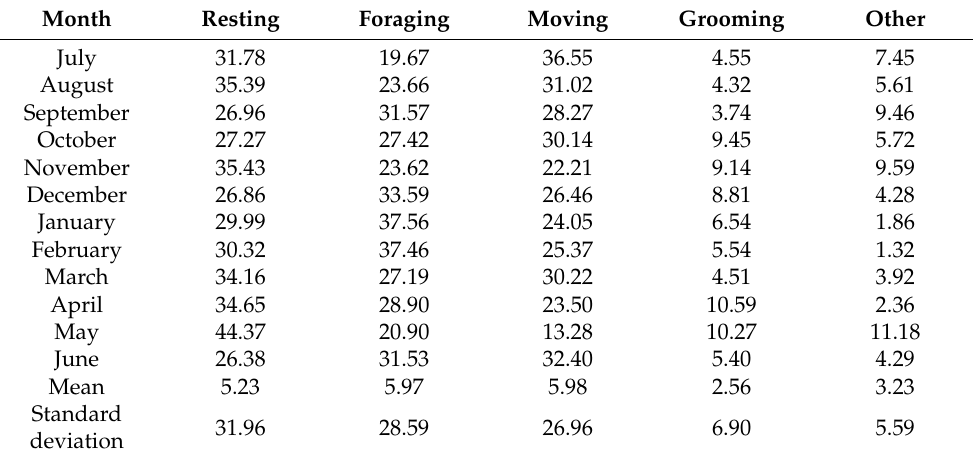
Figure 2. Diurnal activity patterns of Tibetan macaques at Tianhu Mountain County Nature Reserve.